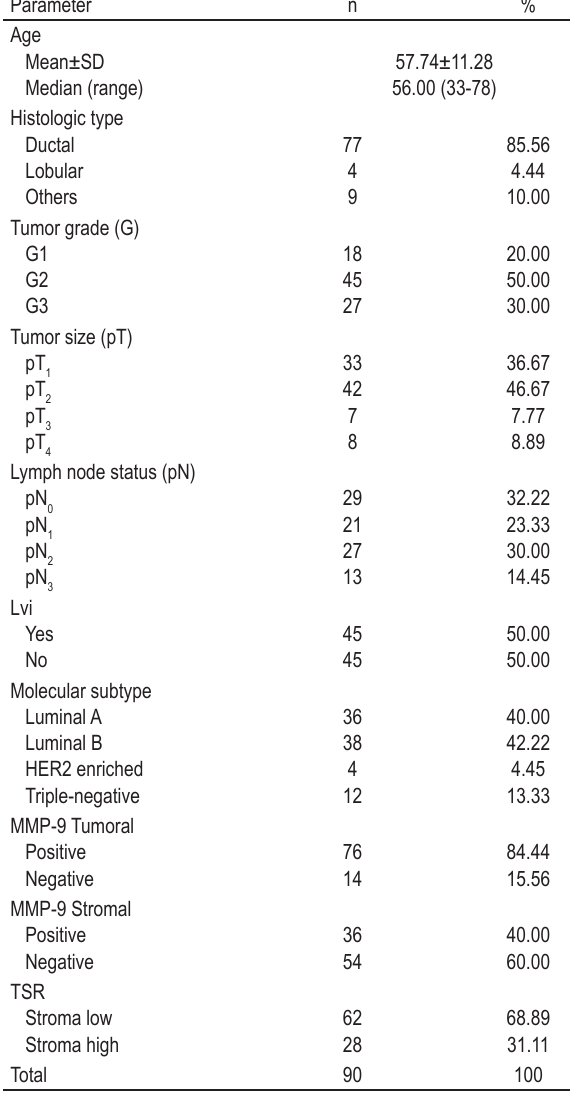
TABLE 1. Clinical, histopathological, and immunohistochemical data of 90 patients with breast cancer